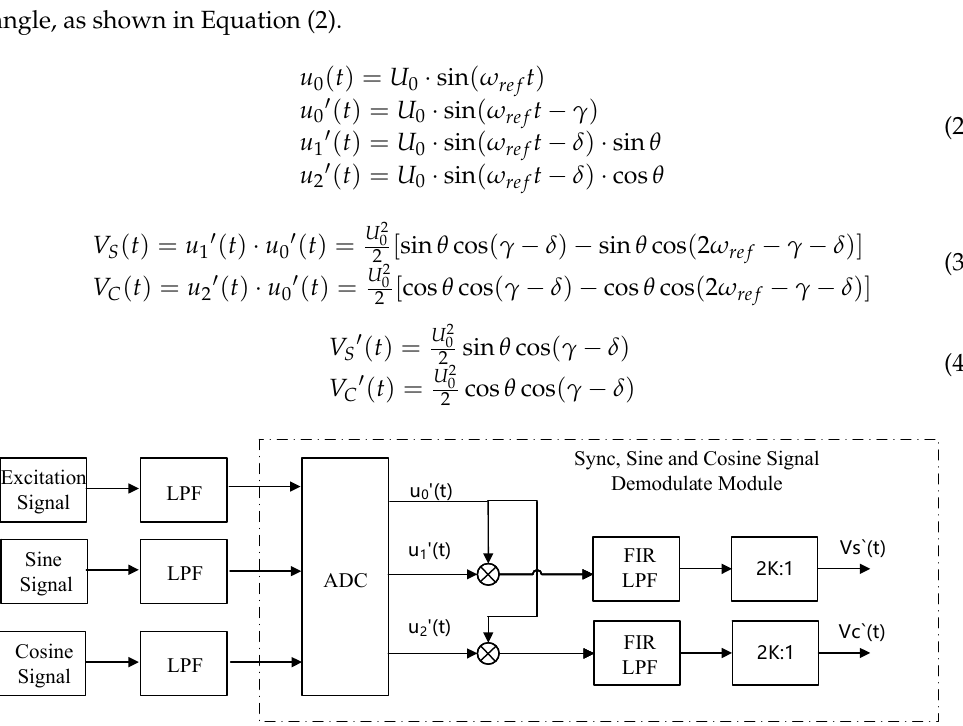
Figure 2. Schematic diagram of the resolver position redundancy decoding scheme.